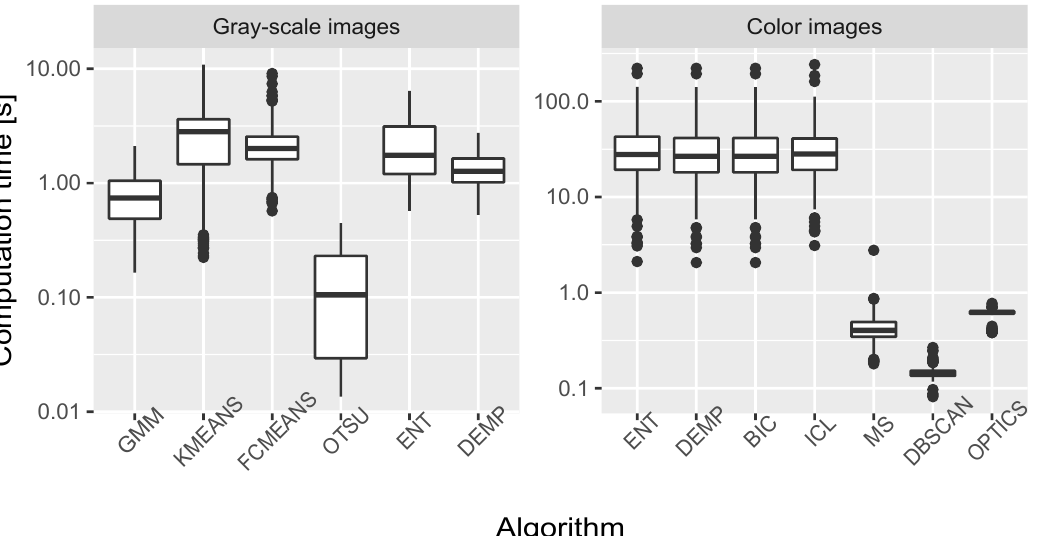
Figure 10. Boxplots of the distribution of computational time using different clustering algorithms for the two datasets used (the dataset for crack segmentation is referred to as gray-scale images and the dataset for Berkley image segmentation is referred to as color